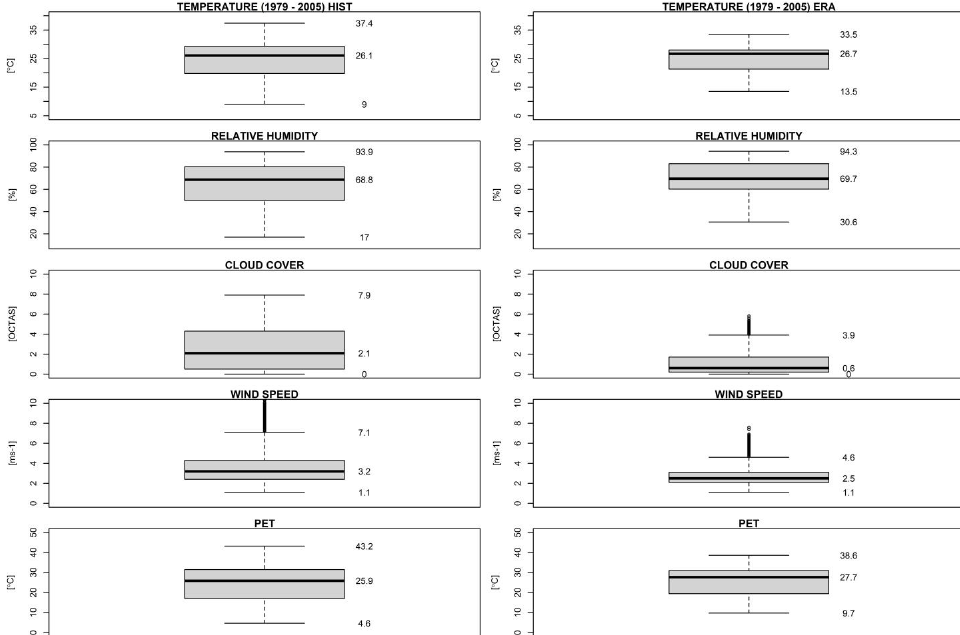
Figure 2. Represents the descriptive statistics of daily temperature, daily relative humidity, daily cloudy cover, daily wind speed, and daily PET extracted from Era-Interim (ERA) and CORDEX (HIST) over WB during the period from 1979 to 2005.